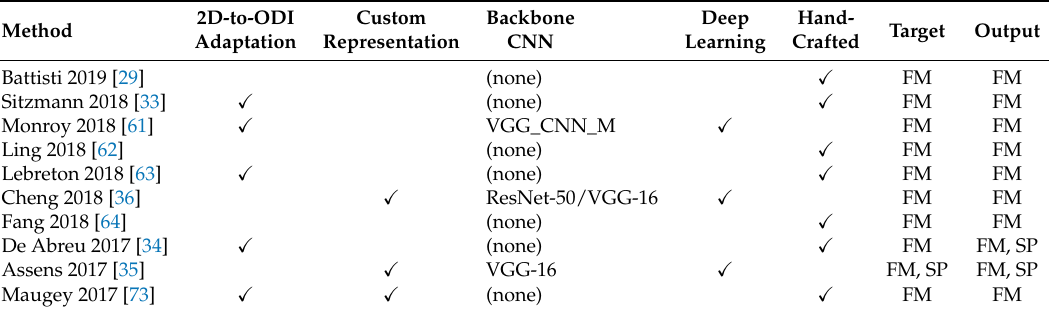
Table 1. Characteristics of recent methods for visual saliency estimation in omnidirectional images. The “Target” column indicates the nature of the ground truth used to train or develop the methods, while “Output” describes what data they are explicitly able to generate (FM = Fixation maps, SP =